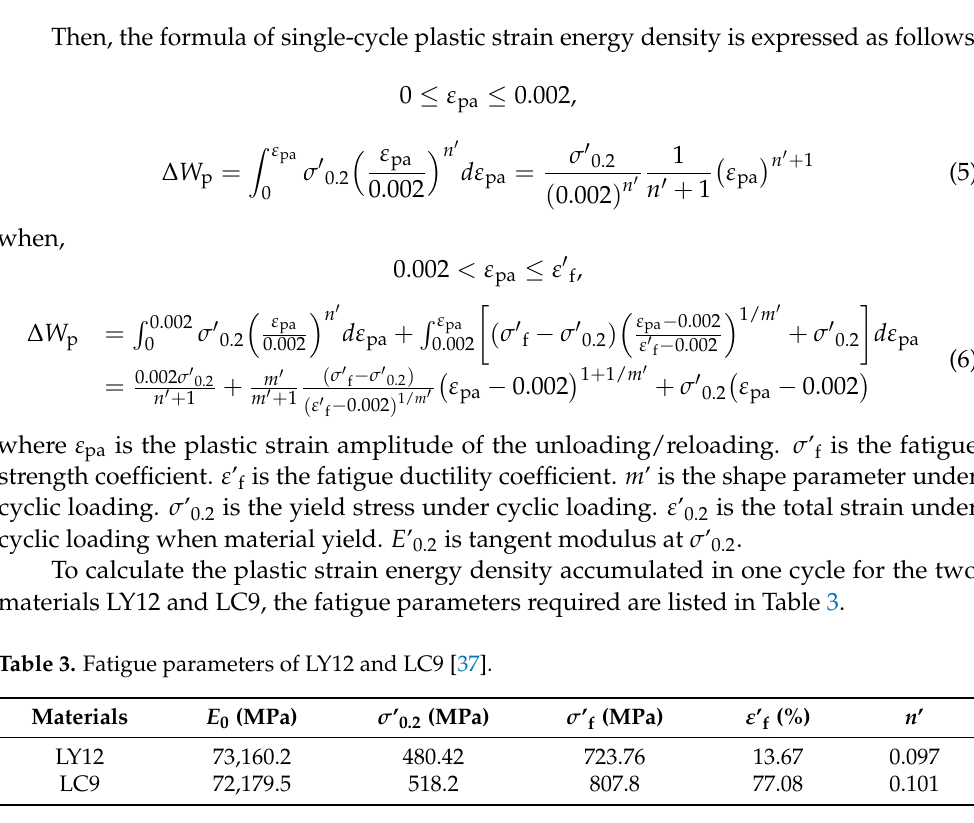
Figure 3. Stress–strain curve of a single cycle.